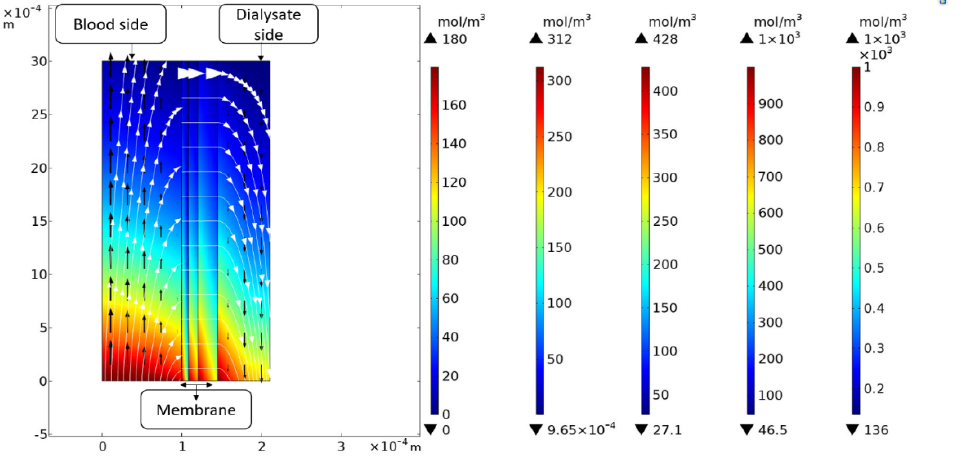
Figure 3. Axisymmetric concentration contour of urea at both blood and dialysate side and across the membrane.